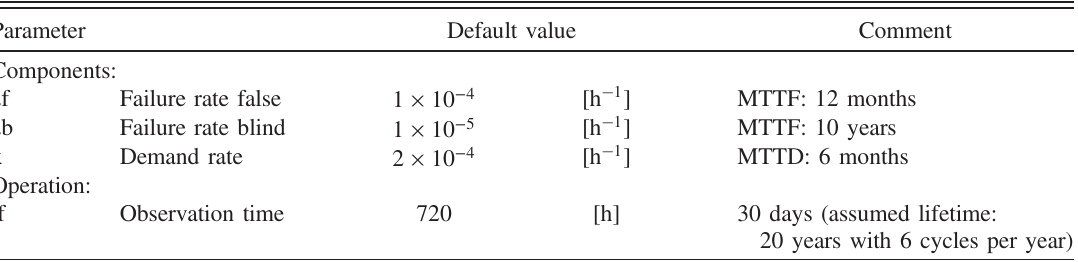
TABLE II. Default input